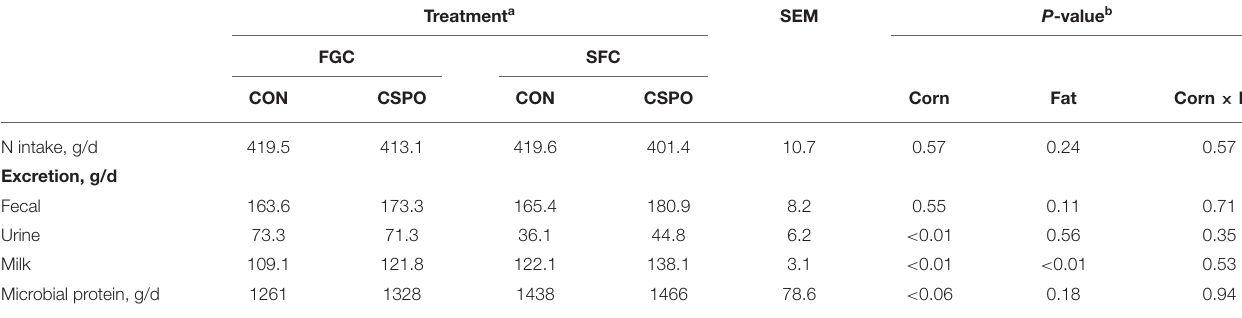
TABLE 2 | Nitrogen (N) intake, nitrogen excretion, and rumen microbial protein of dairy cows receiving the treatment diets (Experiment 1). Treatment a SEM P -value b FGC SFC CSPO CSPO Corn Fat Corn ×